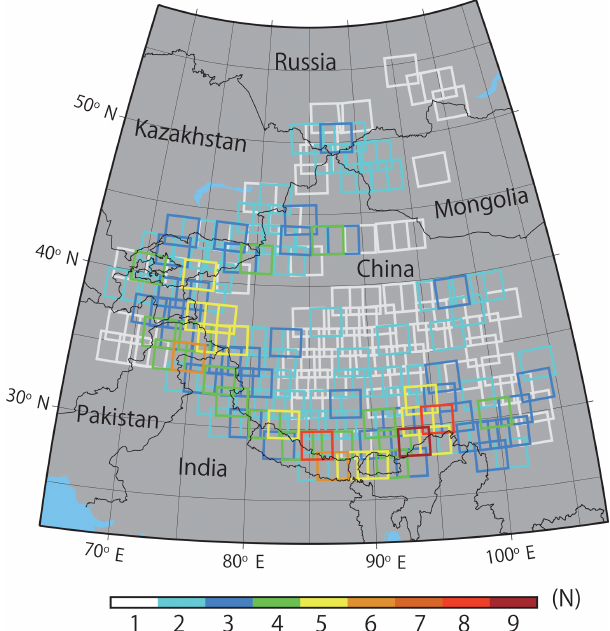
Figure 1. Footprints of the Landsat scenes used in the GGI18. Colours indicate the number of scenes used to delineate glacier out-